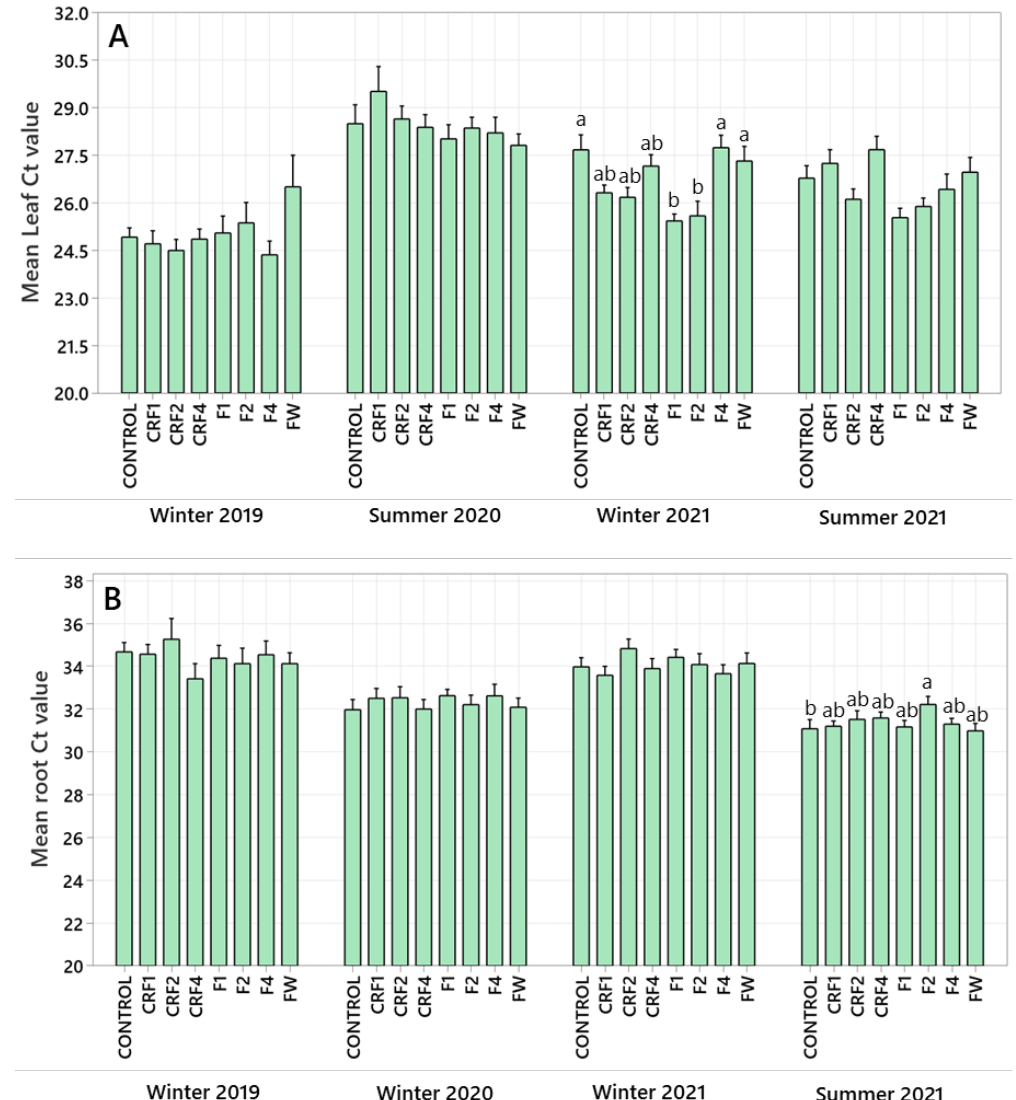
Figure 3. Candidatus Liberibacter asiaticus Ct values measured in citrus leaves ( A ) and roots ( B ) from Winter 2019 to Summer 2021. Six-year-old HLB-affected ‘Ruby Red’ grapefruit trees grafted on sour orange rootstock were used. A one-way analysis of variance (ANOVA) with a Tukey honestly significant difference (HSD) test was used to deter-mine significant differences between means. Letters indicate statistically significant differences ( p ≤ 0.05). Bars represents standard error.